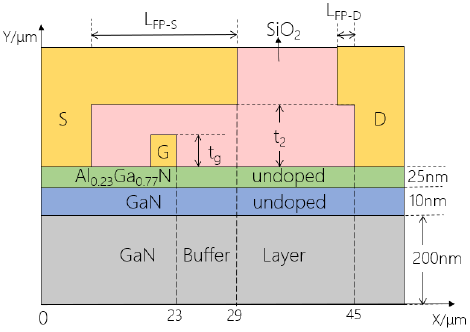
Figure 6. Device structure with FP-S and FP-D analyzed in this study.